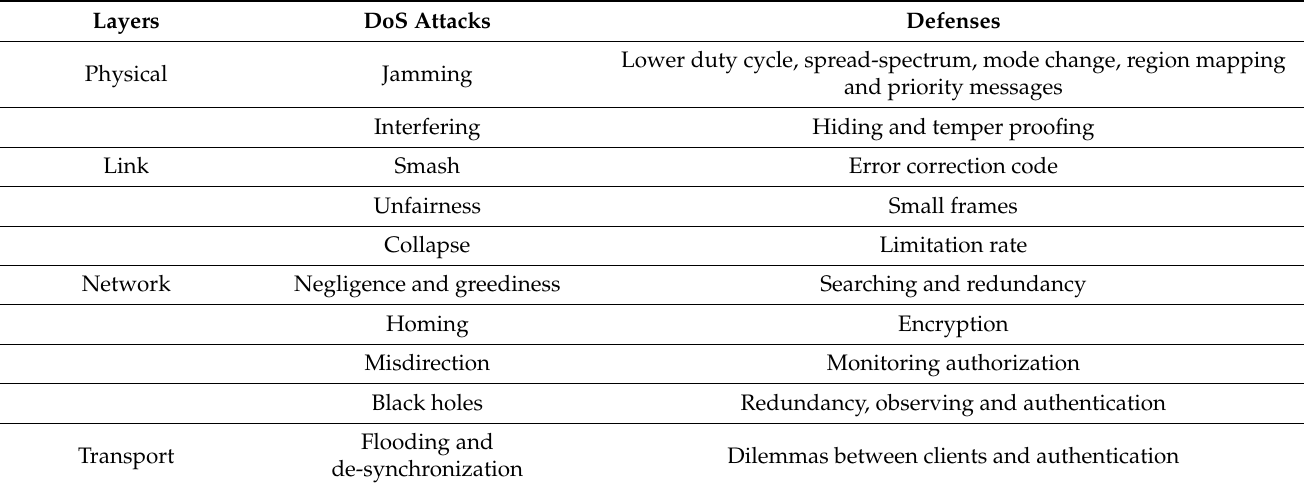
Table 1. “WBAN Security attacks and defences”